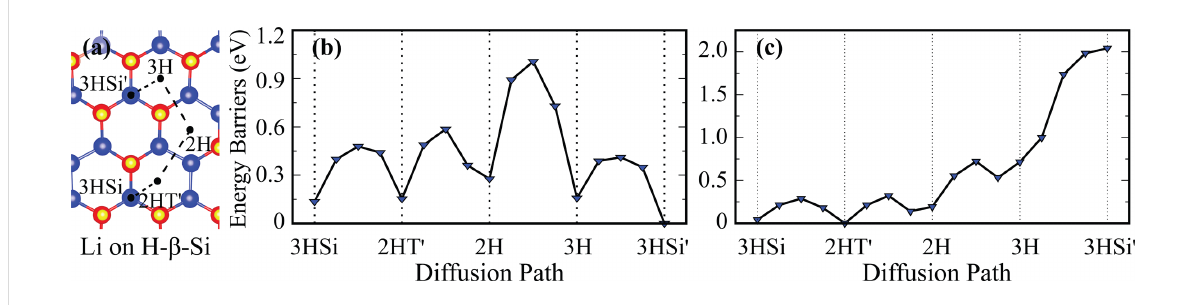
Figure 3: (a) Top view of possible adsorption sites for Li atom on H- β -Si. Energy barrier graphs of (b) the first and (c) the second Li atom on H- β -Si. A possible diffusion path of Li atom is illustrated by dashed black lines.